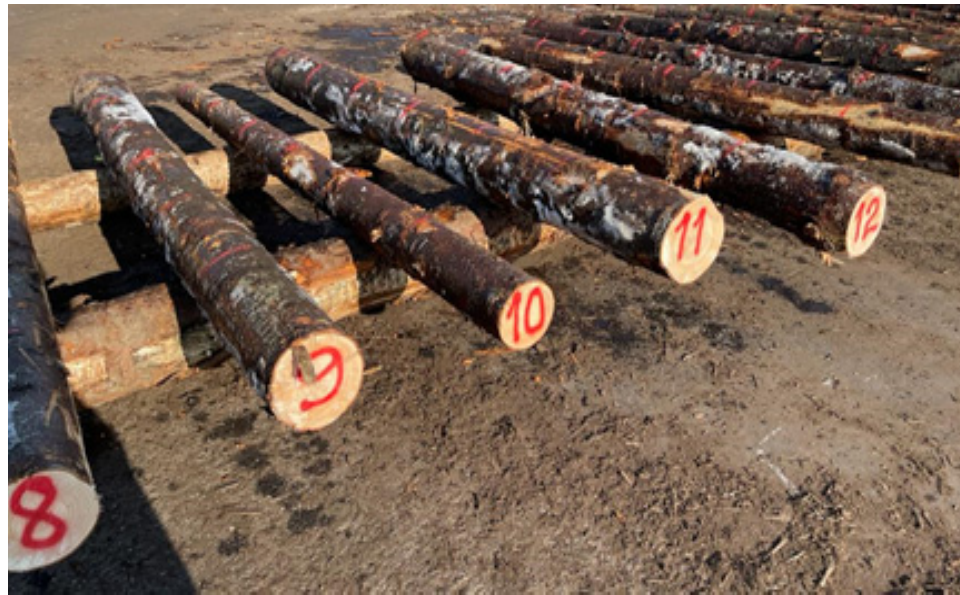
Figure 1. An example of log placement to facilitate measurements. Note: numbers painted in red stand for the identification numbers of the logs.